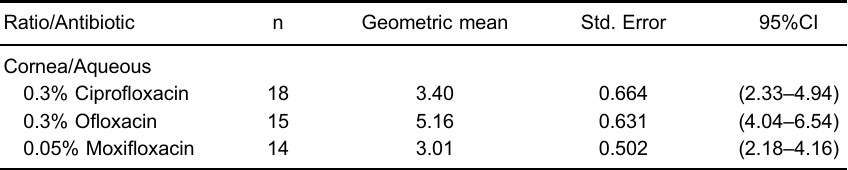
Table 4. Ratios between the corneal and aqueous humor concentrations of